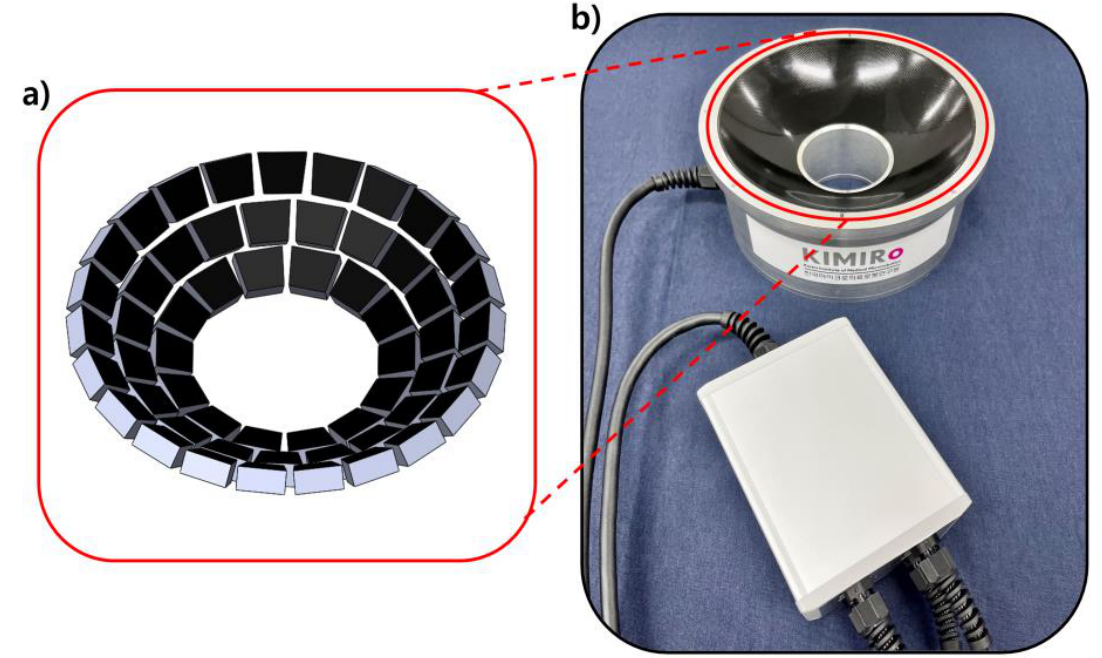
Figure 1. Overview of 56-channel model: ( a ) Arrangement of 56 transducers; ( b ) Photograph of the model: (Top) 56-ultrasound array body, (Bottom) Relay box for distribution of 56 channels.